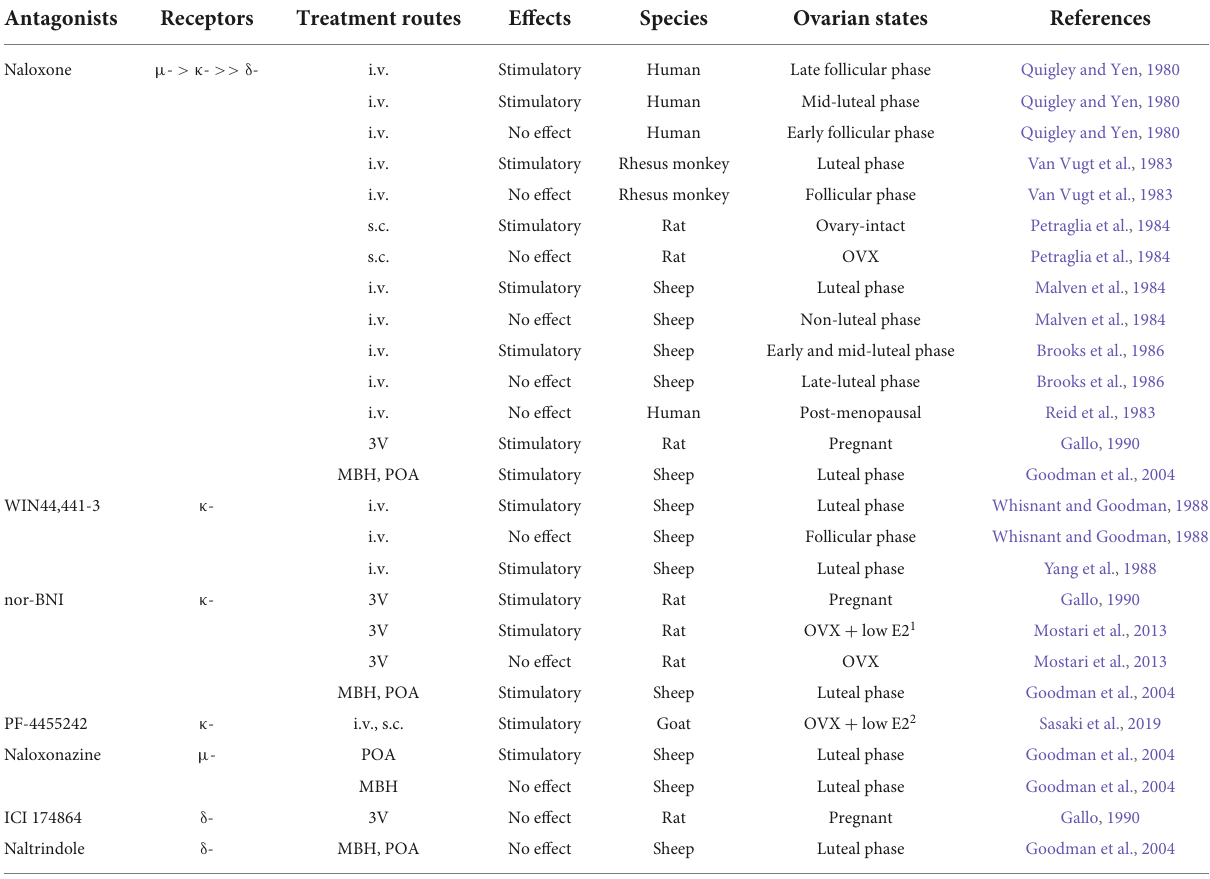
TABLE 3 Effects of opioid receptor antagonists on tonic luteinizing hormone (LH) secretion in female mammals. Antagonists